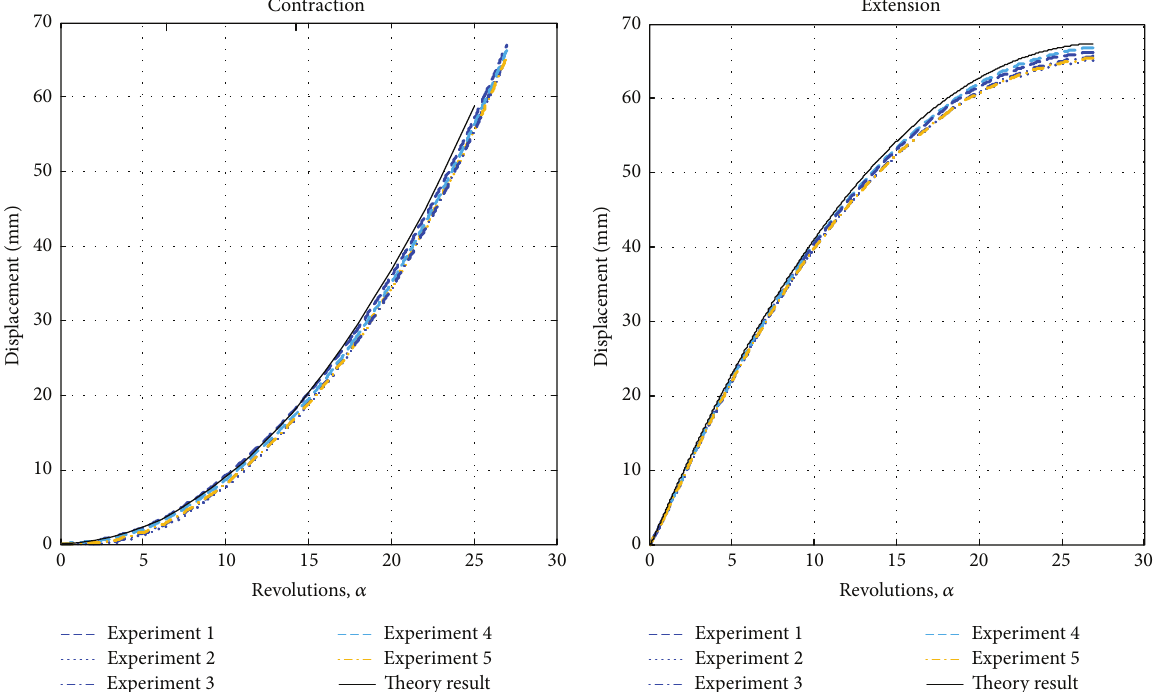
Figure 6: Comparison of theoretical transmission length and experimental measurement for 400mm